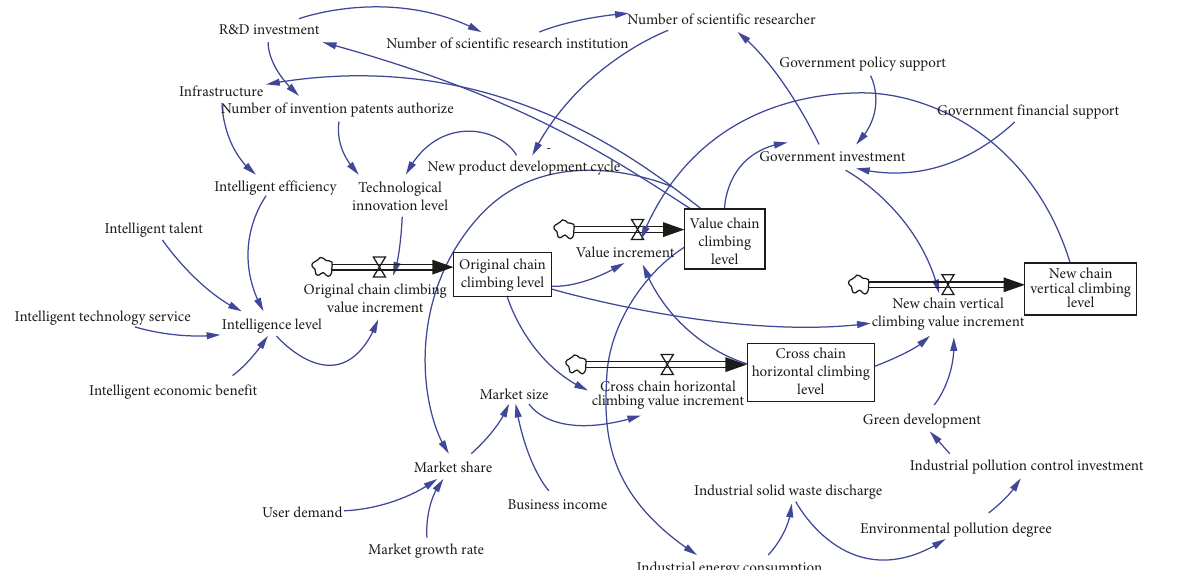
Figure 3: Stock-flow chart of the value chain climbing under intelligent